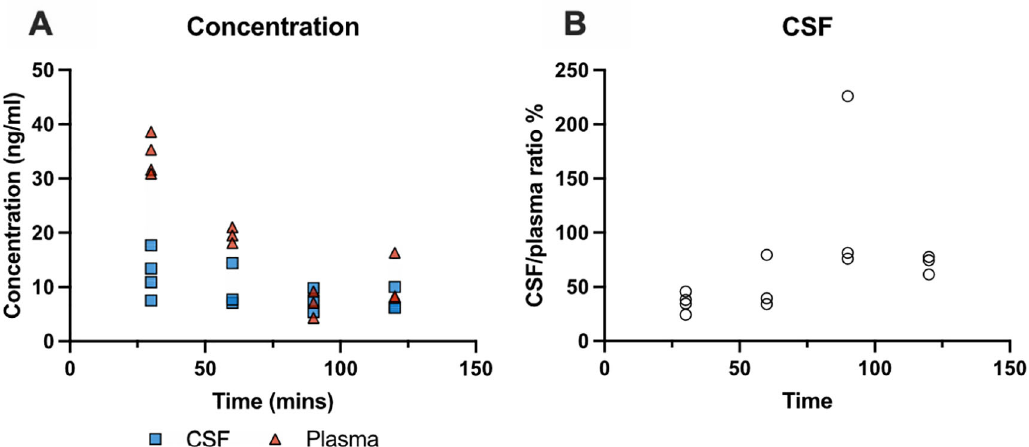
Figure 2. Time course of olanzapine entry into cerebrospinal fluid (CSF) in P4 rats. (A) Olanzapine concentration (ng/ml) in CSF and plasma 30 – 120 min after a single intraperitoneal ( i.p. ) injection of olanzapine (0.15 mg/kg) measured using LC-MS (liquid chromatography coupled with mass spectrometry). (B) CSF/plasma olanzapine concentration ratios (%). Note each point represents results from an individual animal (n=3 – 4 at each time point).